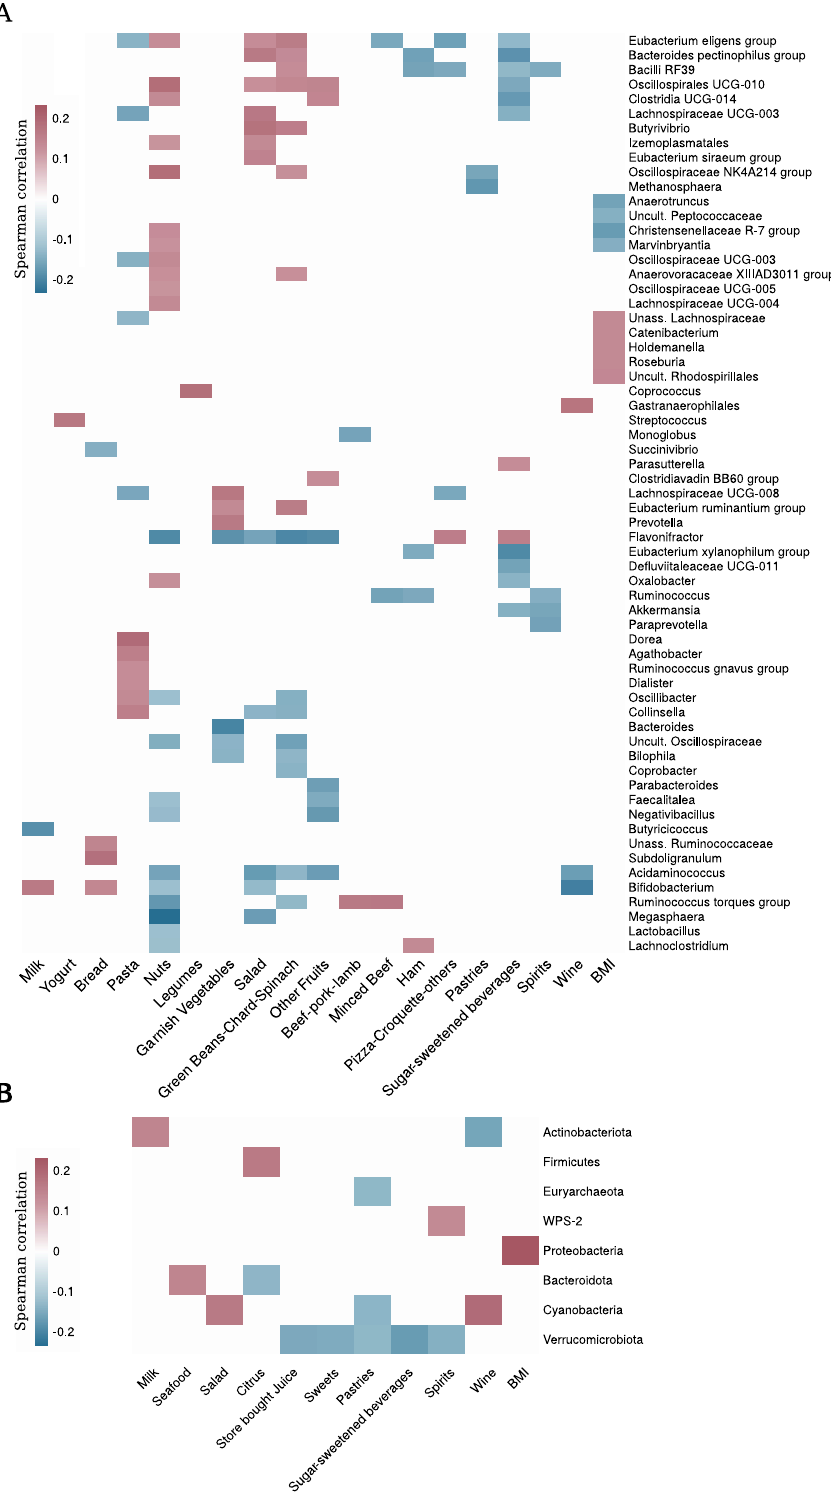
Figure 3. Associations of microbial taxa ( A : Genera; B : Phyla) with the consumption of particular foods or food groups. Only significant associations are shown (FDR-adjusted p -value < 0.05). Only taxa or foods/food groups showing at least one significant association are shown. Positive Spearman’s rank correlation coefficients (positive associations) are colored in red, while negative values (negative associations) are colored in blue. A full description of the foods included in each food group can be found in the Supplementary